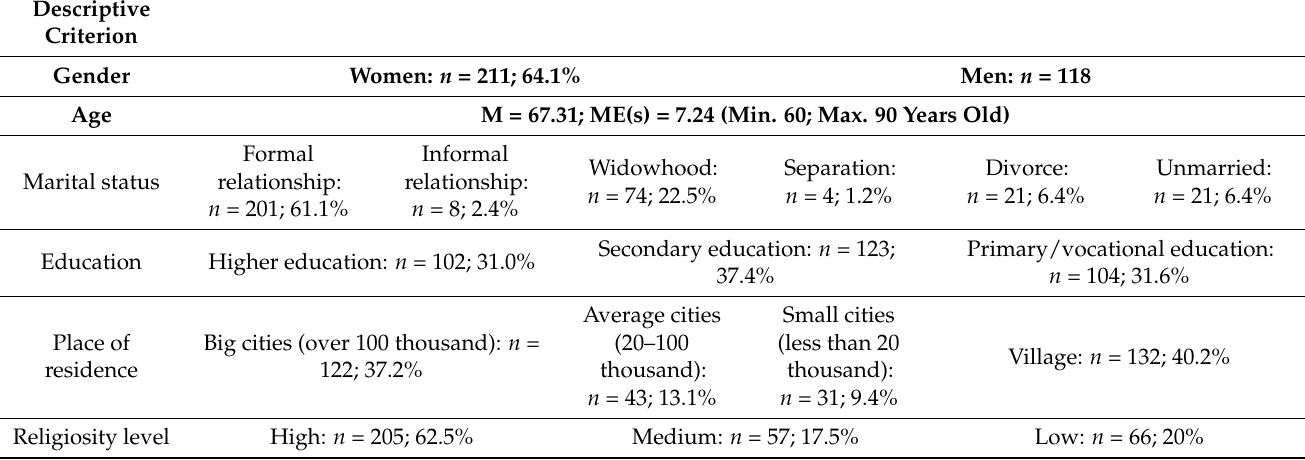
Table 1. Socio-demographic characteristics of the study participants ( n =